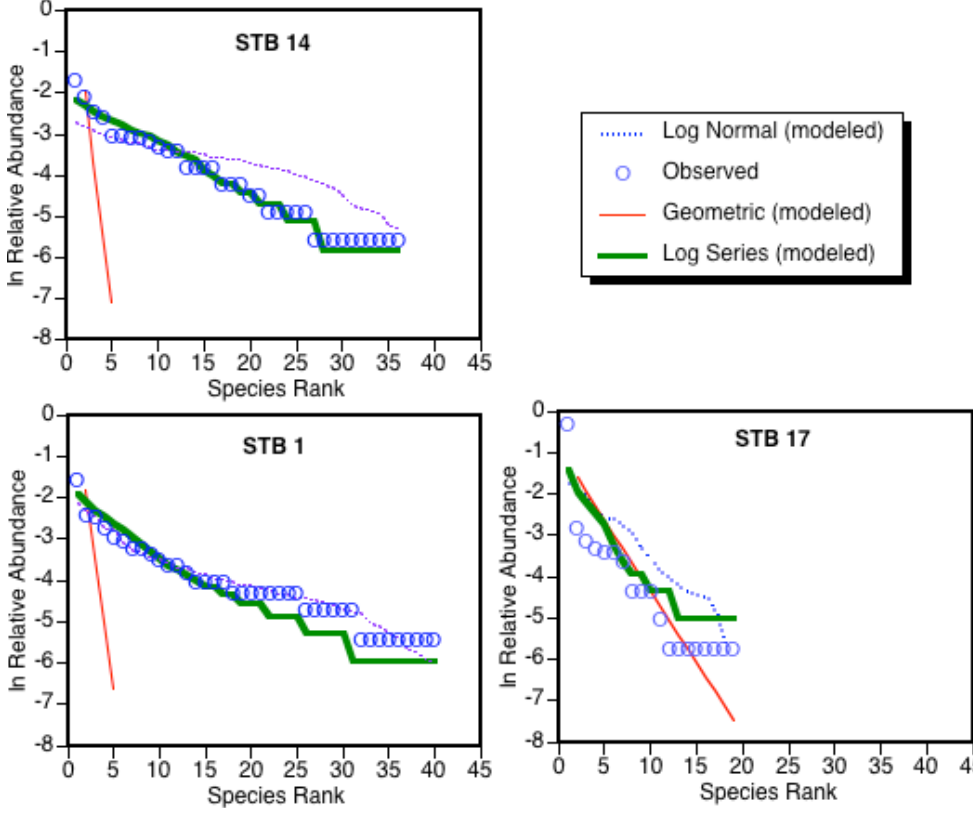
Fig. 5. Examples of species abundance distributions. Station STB 14 shows the most common pattern (15 of 21 data sets) of the log-series distribution providing the closest fit to the actual data. STB 1 was one of 3 data sets in which a log-normal distribution best matched the observed species abundance. STB 17, highly dominated by a single species (Table 4) was the only station for which the geometric distribution provided the closest fit.